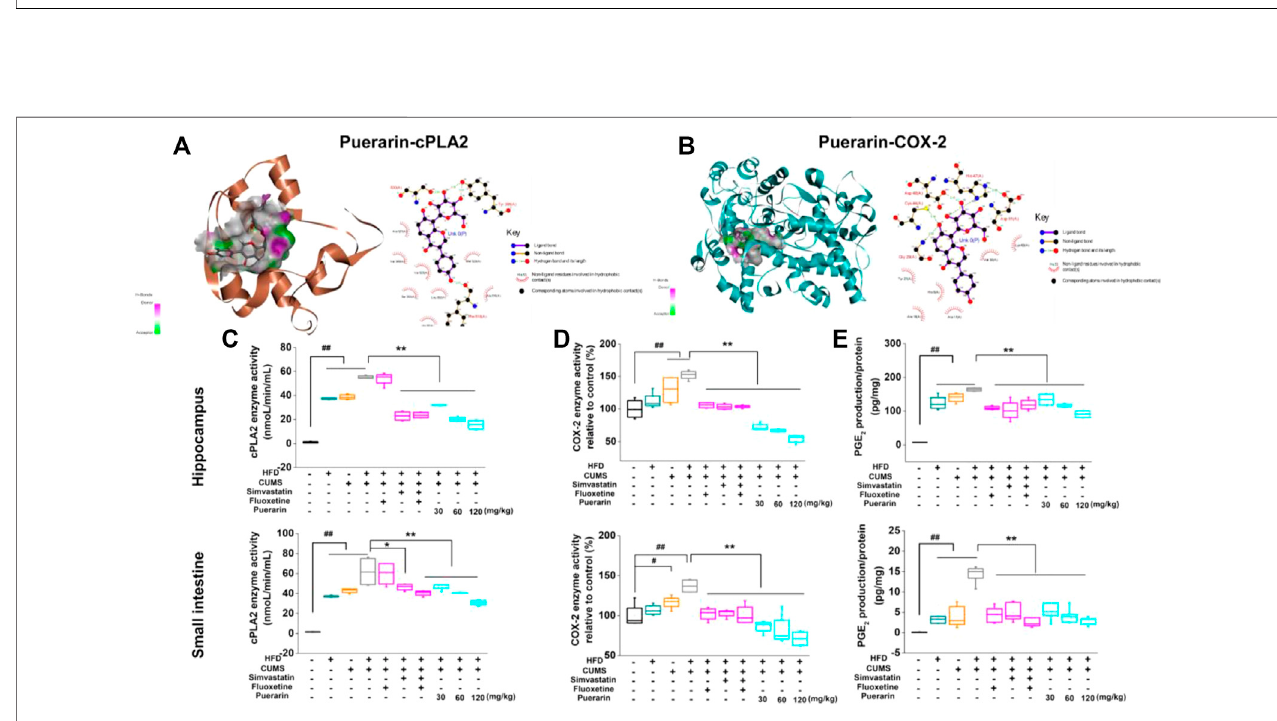
FIGURE 7 | Puerarin inhibited the enzyme activity of cPLA2 and COX-2 and decreased the production of PGE 2 . The 3D and 2D diagrams of the interaction of puerarin-cPLA2 (A) and puerarin-COX-2 (B) by molecular docking. Puerarin inhibited the enzyme activity of cPLA2 and COX-2 in the hippocampus and small intestine. The enzyme activities of cPLA2 (C) and COX-2 (D) , as well as the downstream PGE 2 (E) production, were analyzed by using commercial kits. Values are expressed as mean ± S.E.M ( n (cid:2) 6). # p < 0.05 and ## p < 0.01 vs. the normal control group; * p < 0.05, ** p < 0.01 vs. the HFD/CUMS group.